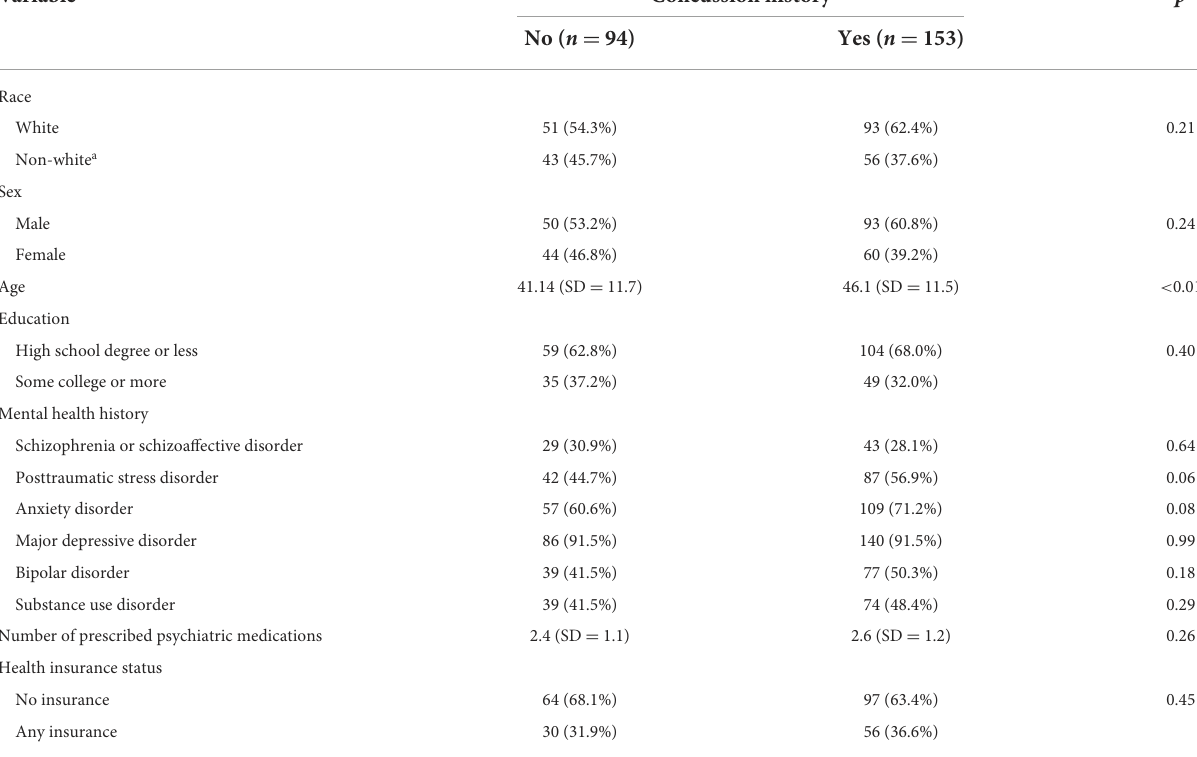
TABLE 1 Participant characteristics ( N =